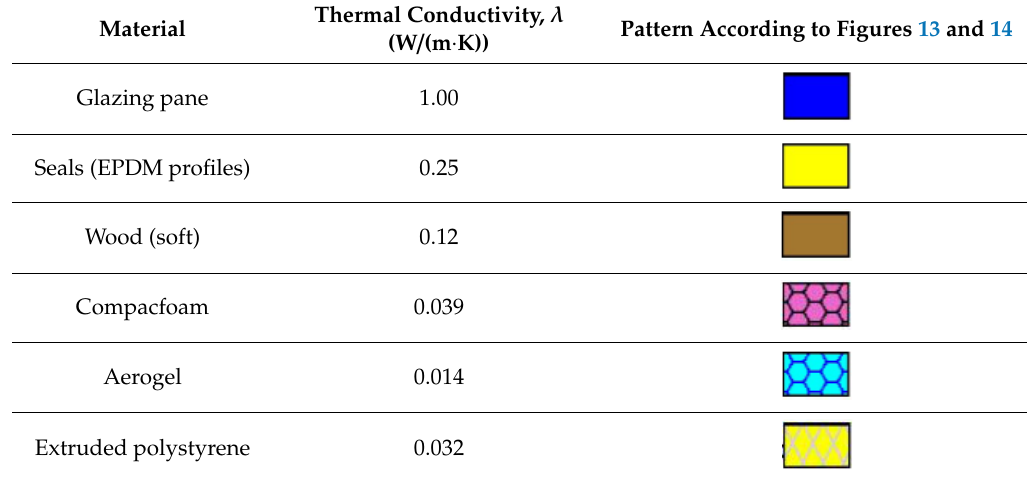
Table 3. Material properties used in the 2D heat transfer calculation.